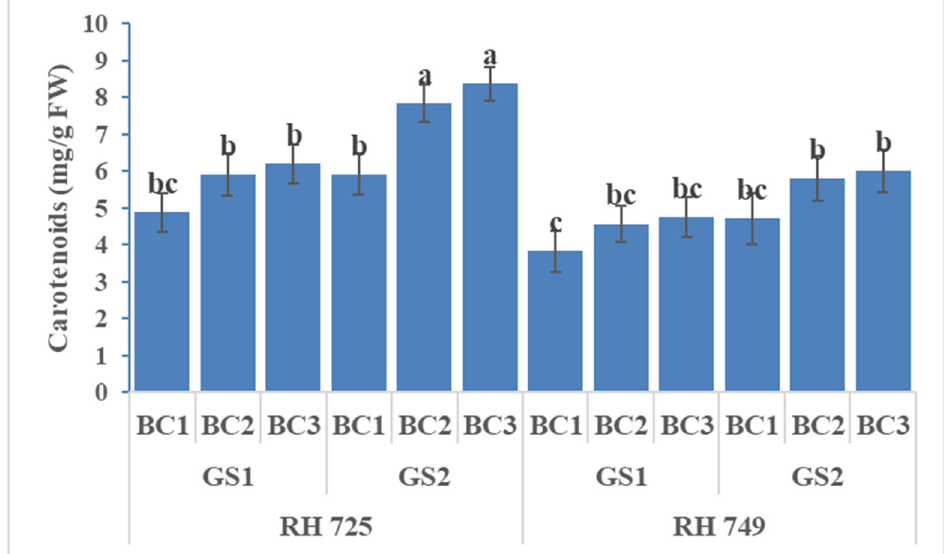
Figure 10. Comparisons of the effects of different concentrations of brassinolide sprays (BC1: control (water spray); BC2: 10 mg BRs/L water; BC3: 20 mg BRs/L water) on the carotenoids content (CC) of drought-tolerant (RH 725) and drought-sensitive (RH 749) Indian mustard cultivars at the flower initiation (GS1) and 50% flowering (GS2) stages. Columns marked by different letters indicate significant differences ( p < 0.05) between treatments based on Duncan’s multiple range test. Error bars denote the standard errors of the mean.